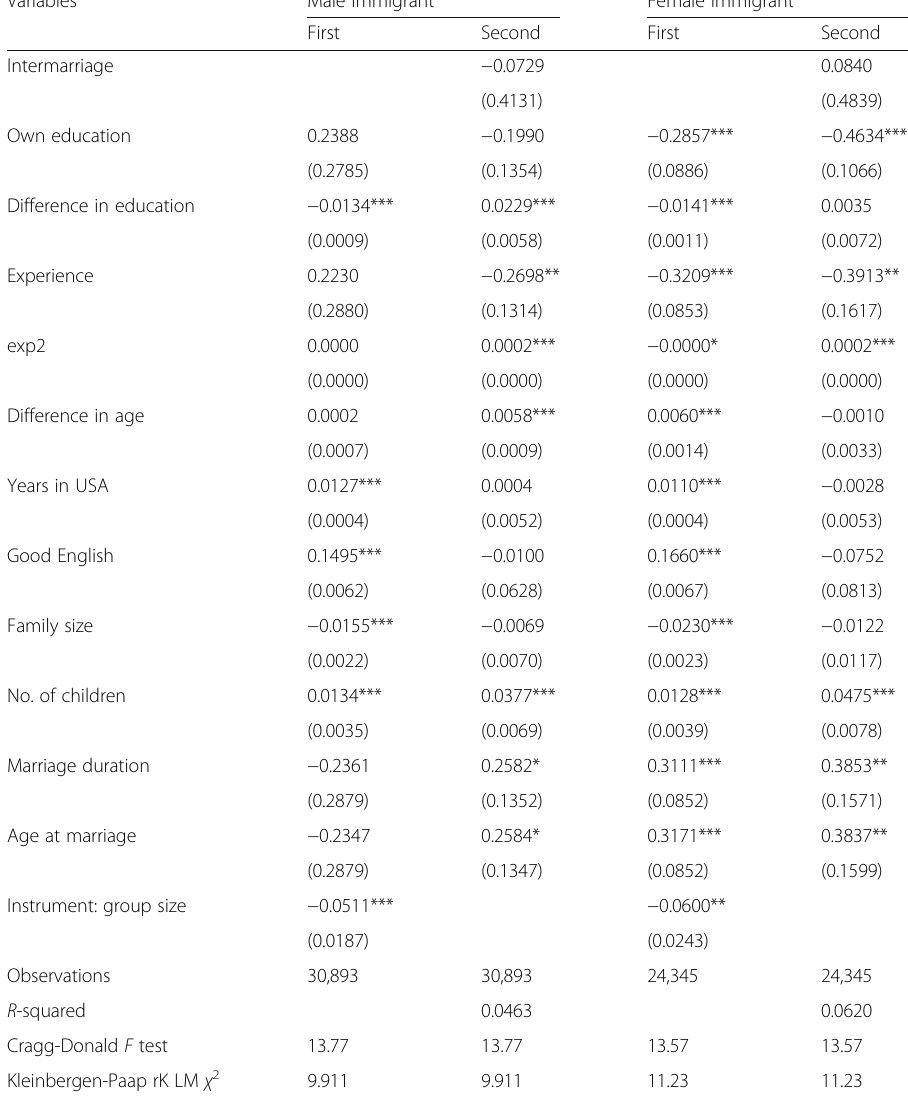
Table 3 IV estimates for the impact of intermarriage on household market hours specialization